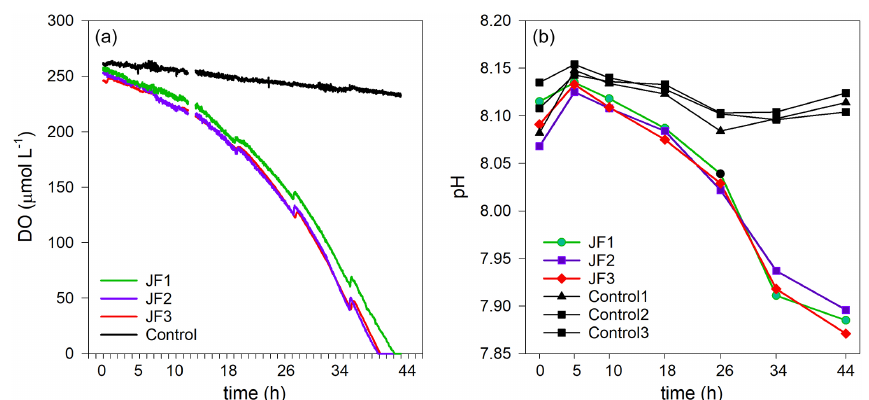
Figure 3. The decomposition of the jellyfish R. nomadica leads to oxygen depletion and acidification in the seawater overlying the sediment. (a) Continuous dissolved oxygen (DO) record in the experimental cylinders enriched with carcasses of the jellyfish R. nomadica (JF1–JF3) and in the controls. (b) pH dynamics in the experimental cylinders, including jellyfish and in the controls. N = 3. The temperature was kept relatively constant at 27–28 ◦ C. The slight increases in DO concentrations throughout the incubation period indicate water compensation during discrete sampling events.